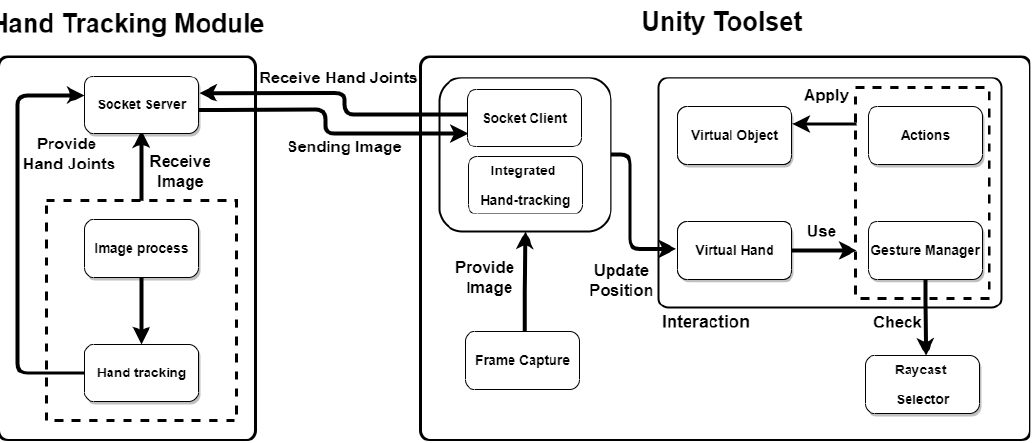
Figure 2. Hand interaction toolset architecture.